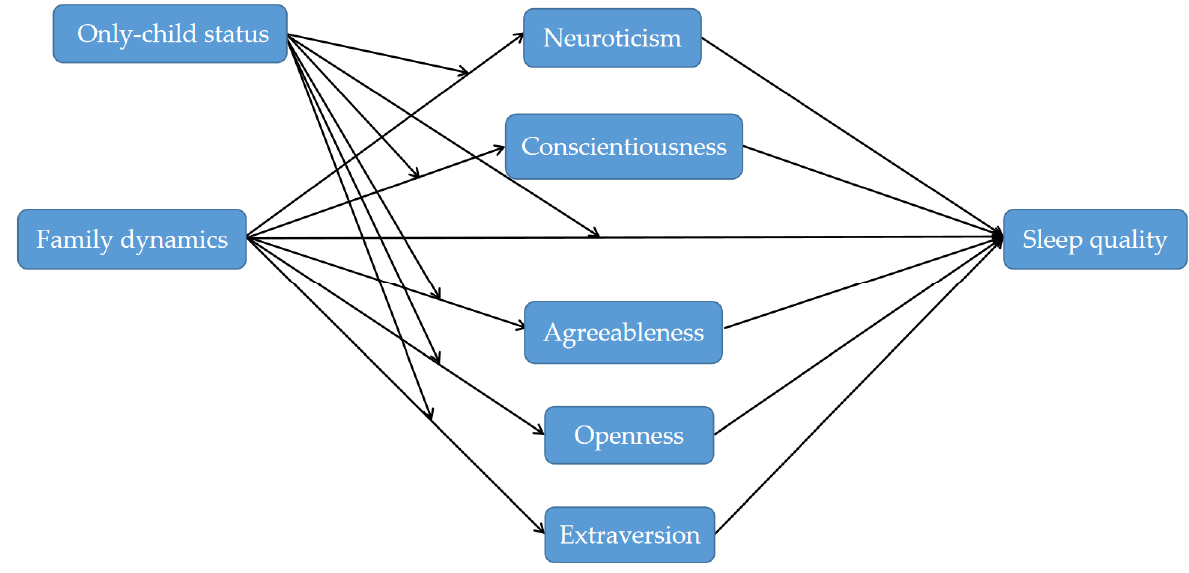
Figure 1. The hypothesized